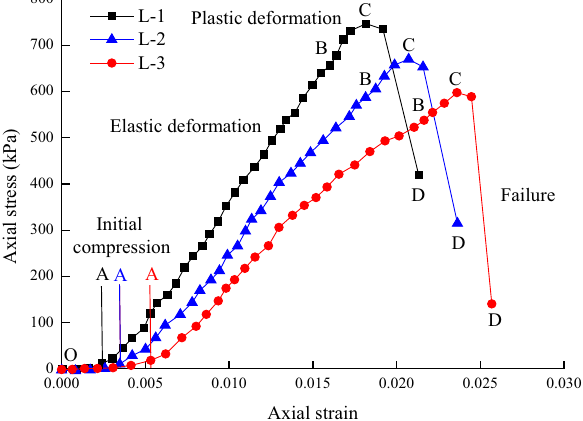
Fig. 4 Experiment procedure